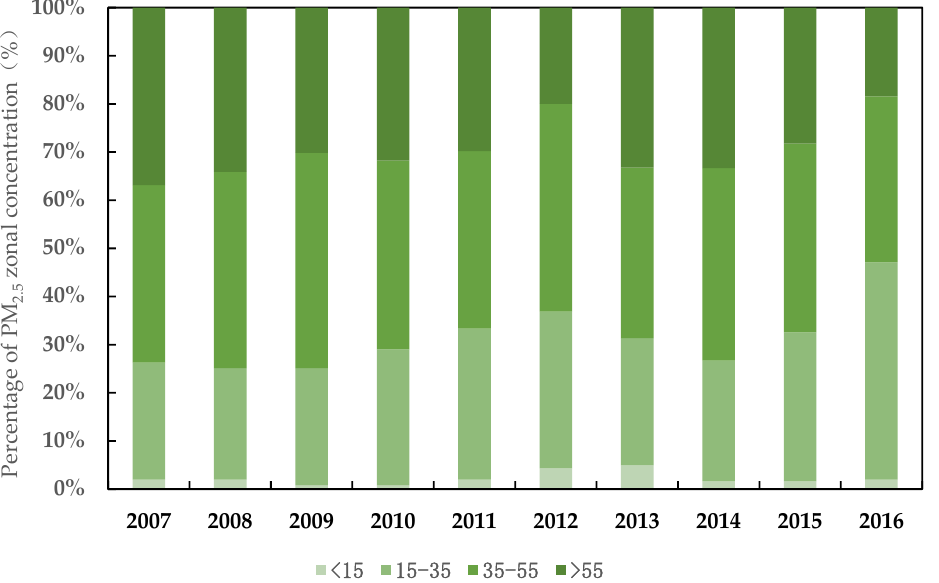
Figure 1. The trend regarding PM 2.5 concentration in China’s 255 cities, 2007–2016 ( μ g/m 3 ).